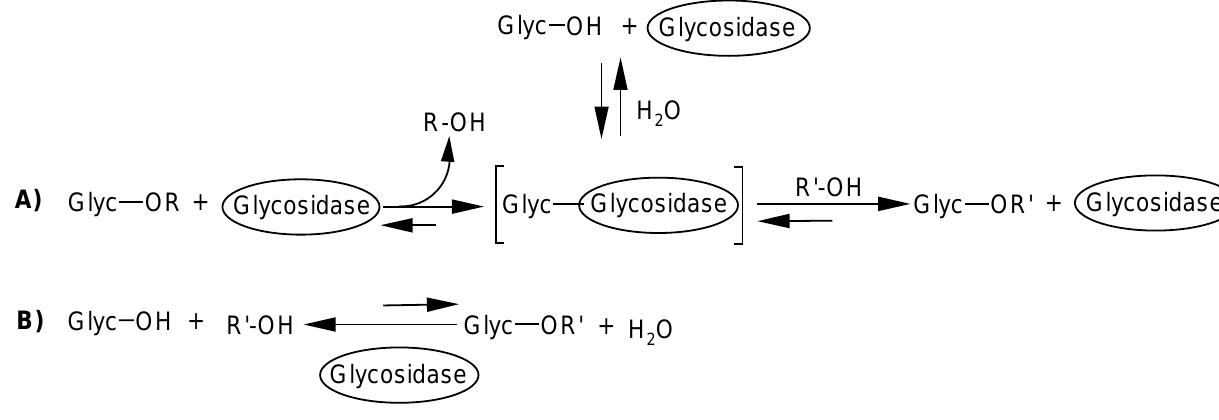
Scheme 1. Different glycosidation methods with glycosidases: A) Transglycosidation; B) Direct